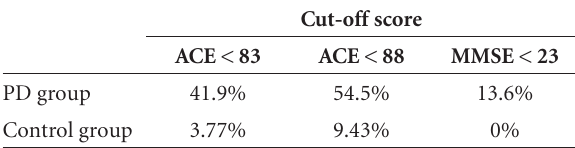
Table 3. Percentage of subjects scoring below cut-off scores sug- gested for Addenbrooke’s Cognitive Examination (ACE) and